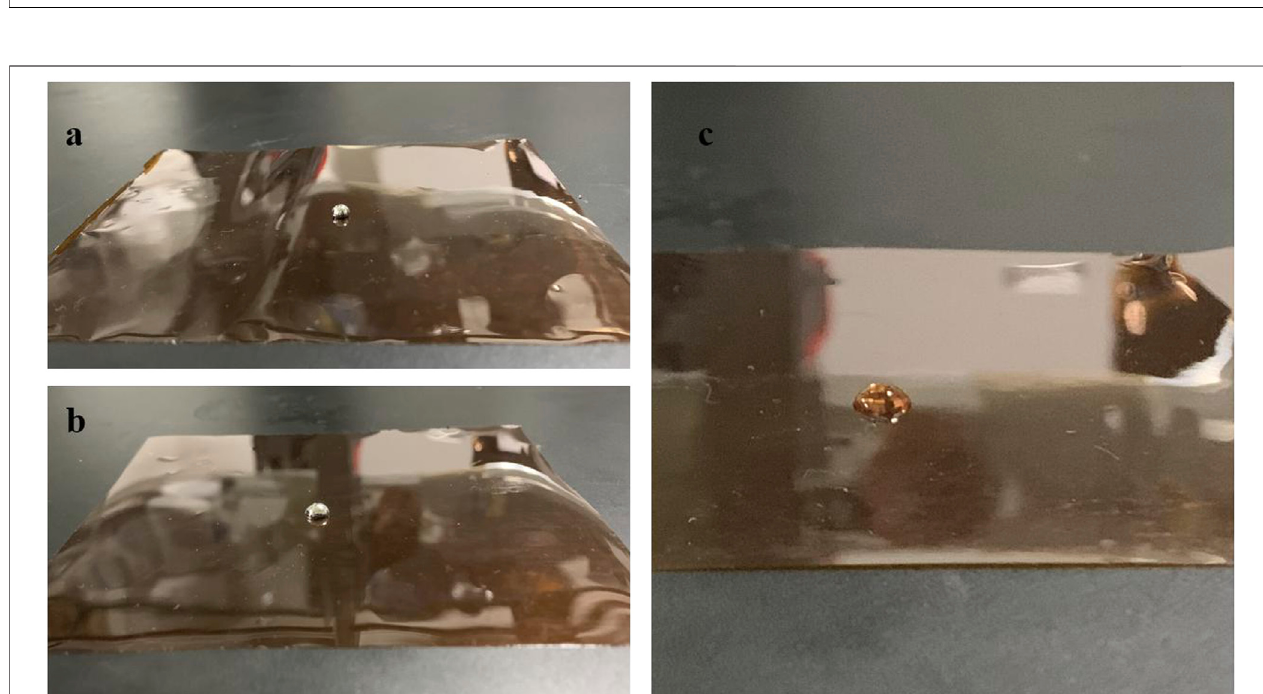
FIGURE 2 | Droplets of mercury, gallium, and water on Kapton ’ s surface. (A) Mercury; (B) gallium; and (C) water.